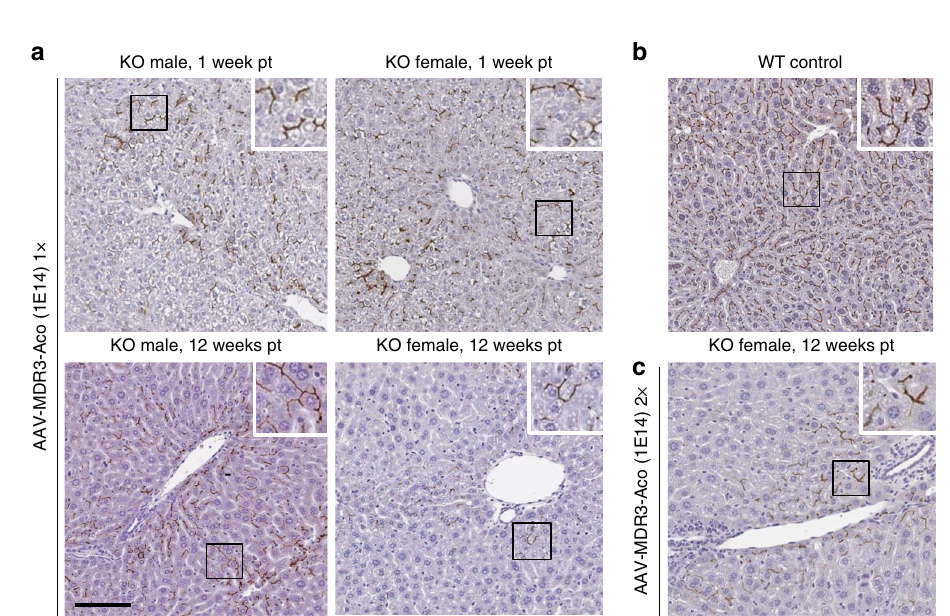
Fig. 2 Analysis of AAV-MDR3-Aco expression in Abcb4 − / − mice. Two-week-old Abcb4 − / − mice (KO) mice received one ( a ) or two ( c ) doses of 1 × 10 14 VG/kg of AAV-MDR3-Aco, and MDR3 expression was analysed at the indicated times after the fi rst dose (pt) by IHC with an anti-MDR3-speci fi c antibody. In c , the second dose was given when mice were 5 weeks old. A female WT mouse is shown as positive control for MDR2 staining ( b ). Representative pictures from one mouse in each group are shown. Scale bar = 100 μ